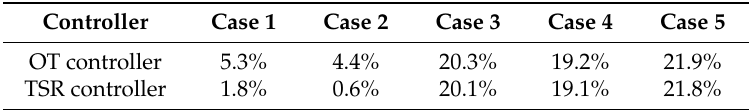
Table 4. Power reduction of two controllers under different simulation cases.